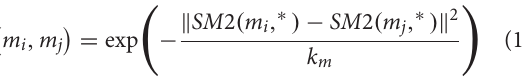
k d is 19 and 15, which represented the number of miRNAs features and disease features after dimensionality